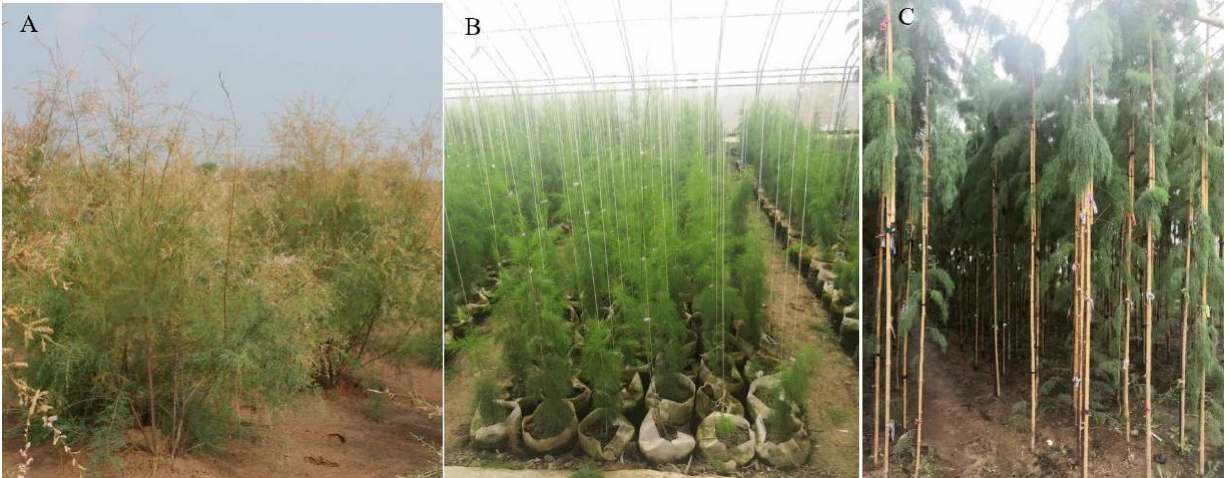
Figure 3. Arborization process of tamarisk seedlings in a greenhouse, ( A ). Three-year-old natural tamarisk seedlings, ( B ). One-year-old arborized tamarisk seedlings, ( C ). Three-year-old arborized tamarisk seedlings.